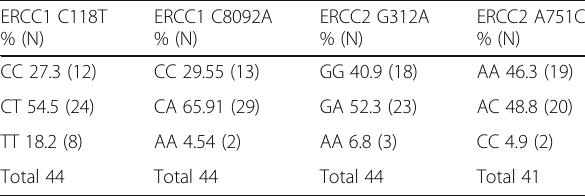
Table 3 Genotypes frequencies in the studied